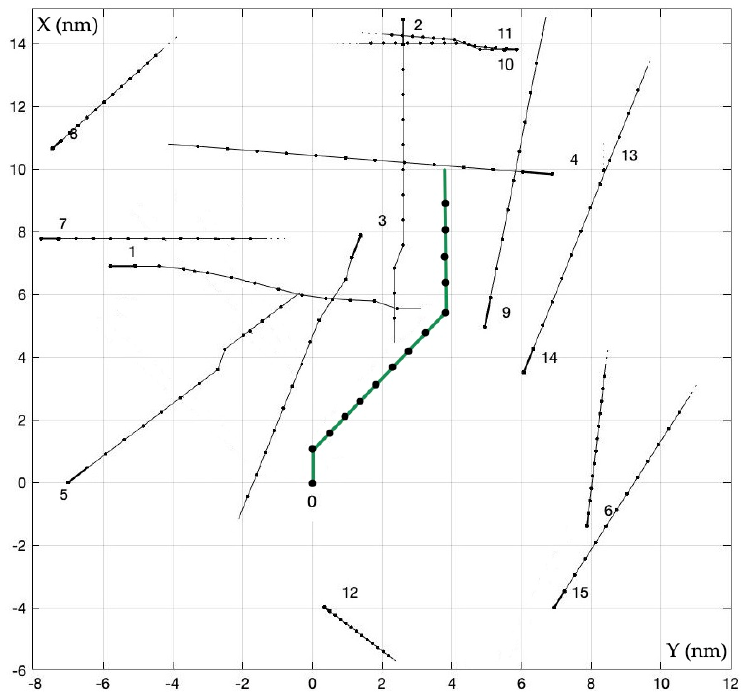
Figure 12. Trajectories of ships in cooperative matrix game ACRGC.